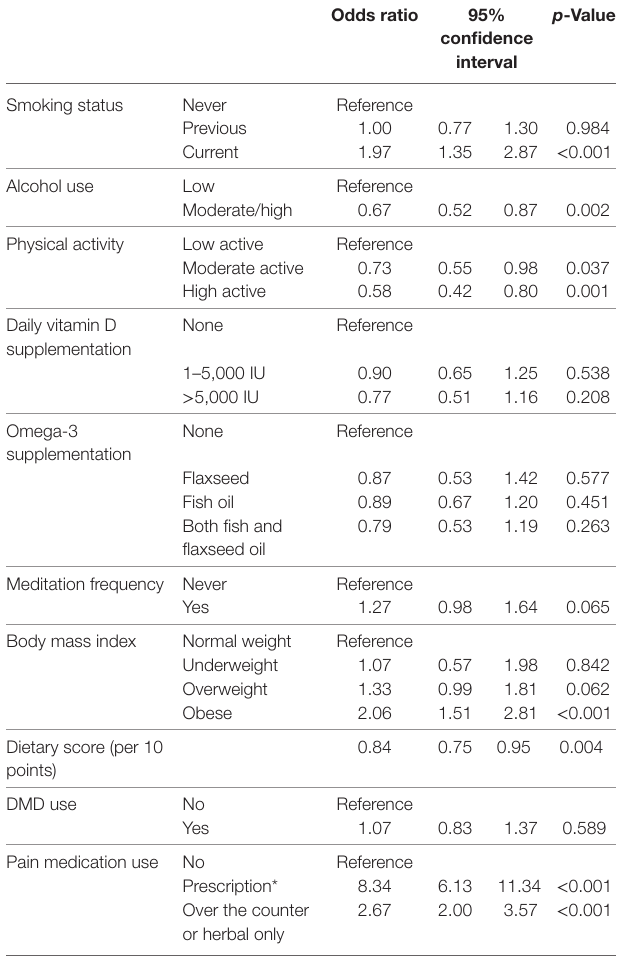
TaBle 3 | Associations between modifiable lifestyle factors and substantial pain, obtained using multivariable regression modeling. a